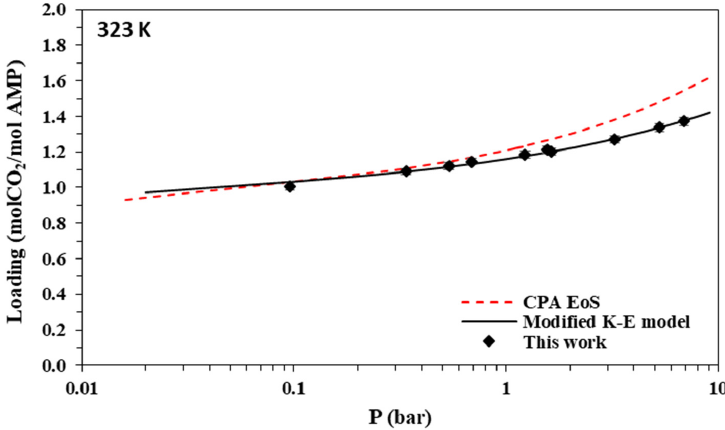
Figure 9. Solubility of CO 2 in aqueous MAPA (30.0% wt.) solutions at 323 K. Experimental data (points, from this work) and correlations (lines) with the CPA equation of state and the modified Kent–Eisenberg model.